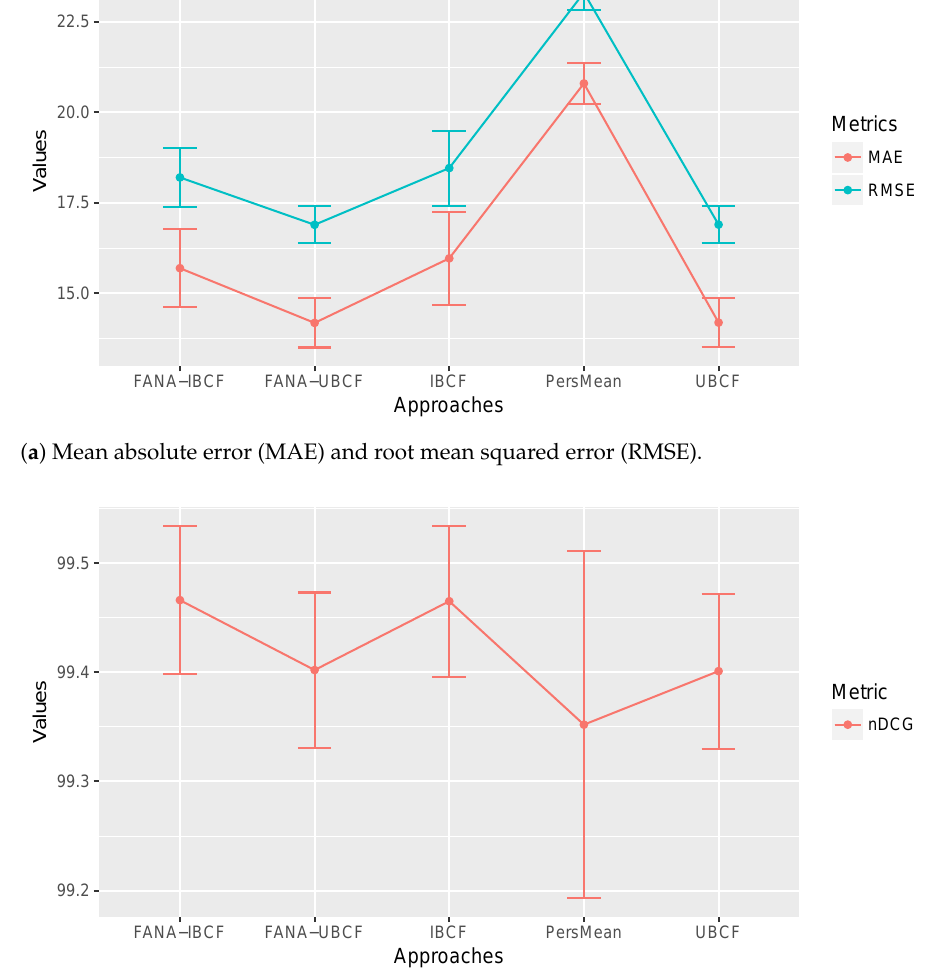
Figure 7. Graphical plots of averages and standard deviations from 5-fold cross validation for MAE, RMSE, and nDCG metrics of IBCF, UBCF, PersMean, and our proposed approach,